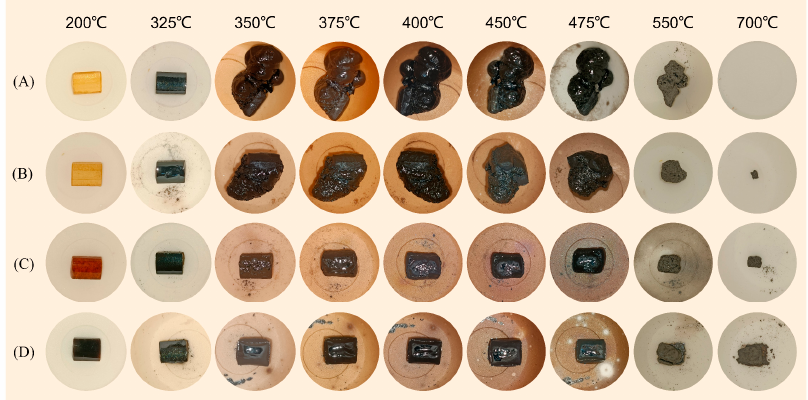
Figure 6. Digital photographs of EP ( A ), 4%TAD/EP ( B ), 3%TAD/1%Zn-PDH/EP ( C ), 4%Zn-PDH/EP ( D ) after being maintained at different temperatures for 15 min in a muffle furnace.